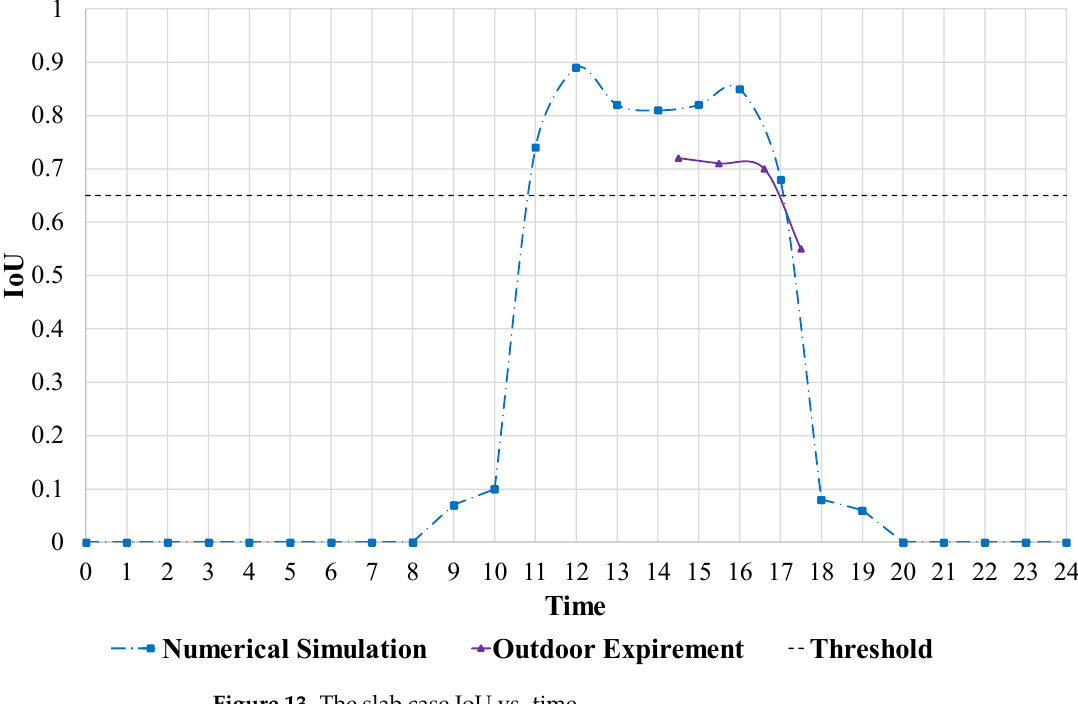
Figure 13. The slab case IoU vs. time.